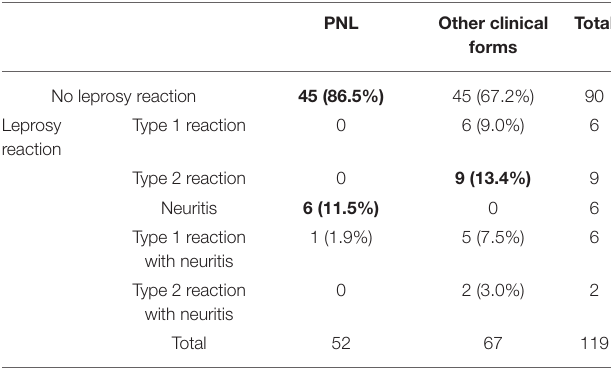
TABLE 2 | Number of patients with pure neural leprosy and other clinical forms TABLE 1 | Number of patients with pure neural leprosy and other clinical forms with leprosy reactions and neuritis after the multidrug therapy. with leprosy reactions and neuritis during the multidrug therapy. PNL Other clinical Total forms No leprosy reaction